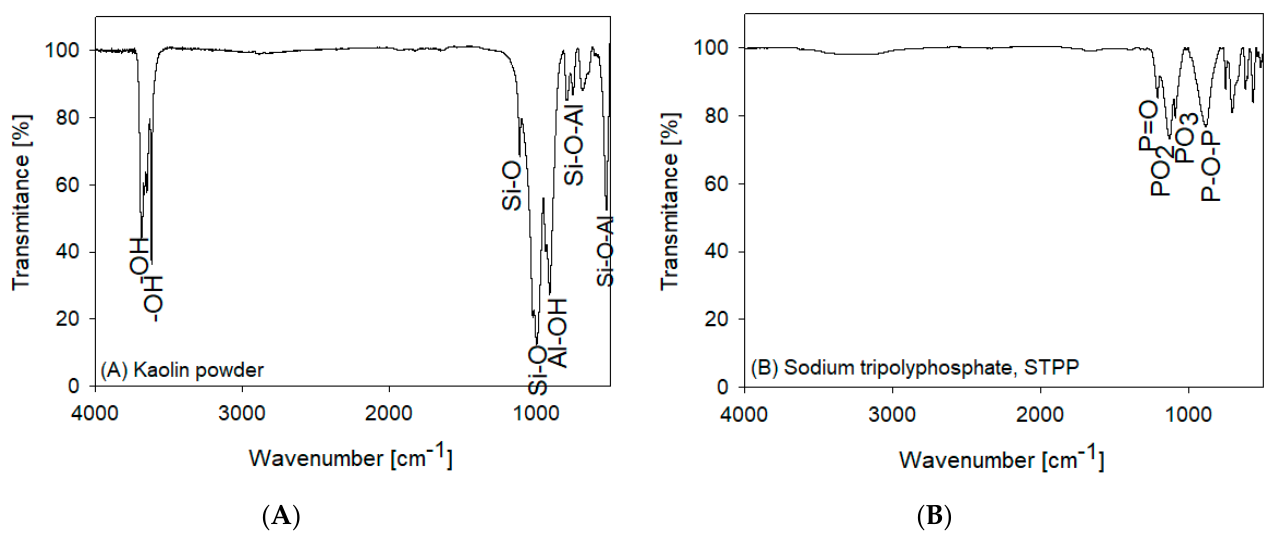
Figure 2. Fourier ‐ transform infrared spectroscopy (FTIR) for: ( A ) kaolin powder; ( B ) sodium tripolyphosphate, STPP.